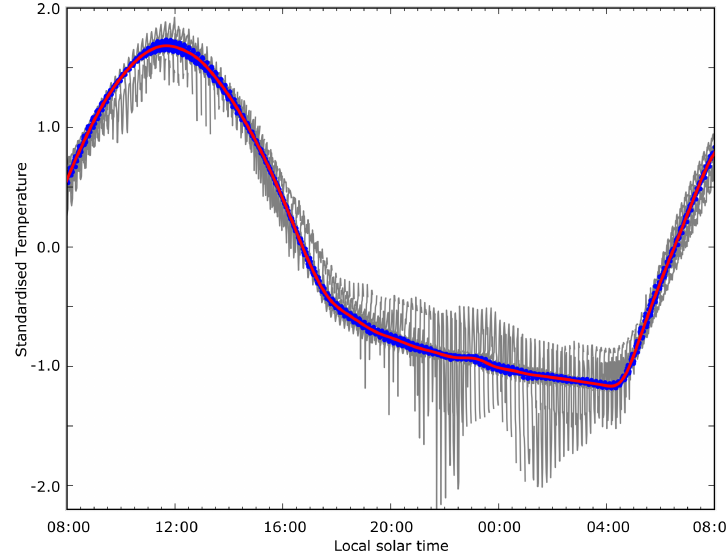
Figure 3. An example of the training data fitting process on a swath for a 24-h period. Grey lines represent the raw median values for each swath from the time of each image, the blue data points are representative of the median brightness temperature of the training data at each local solar time, and the red trend line represents the filtered medians of the training data. (Due to the nature of the filtering process, the lack of data at each end of the data results in anomalous fitting and as such the swath sampling has been extended one hour either side of the 24-h period to minimise these